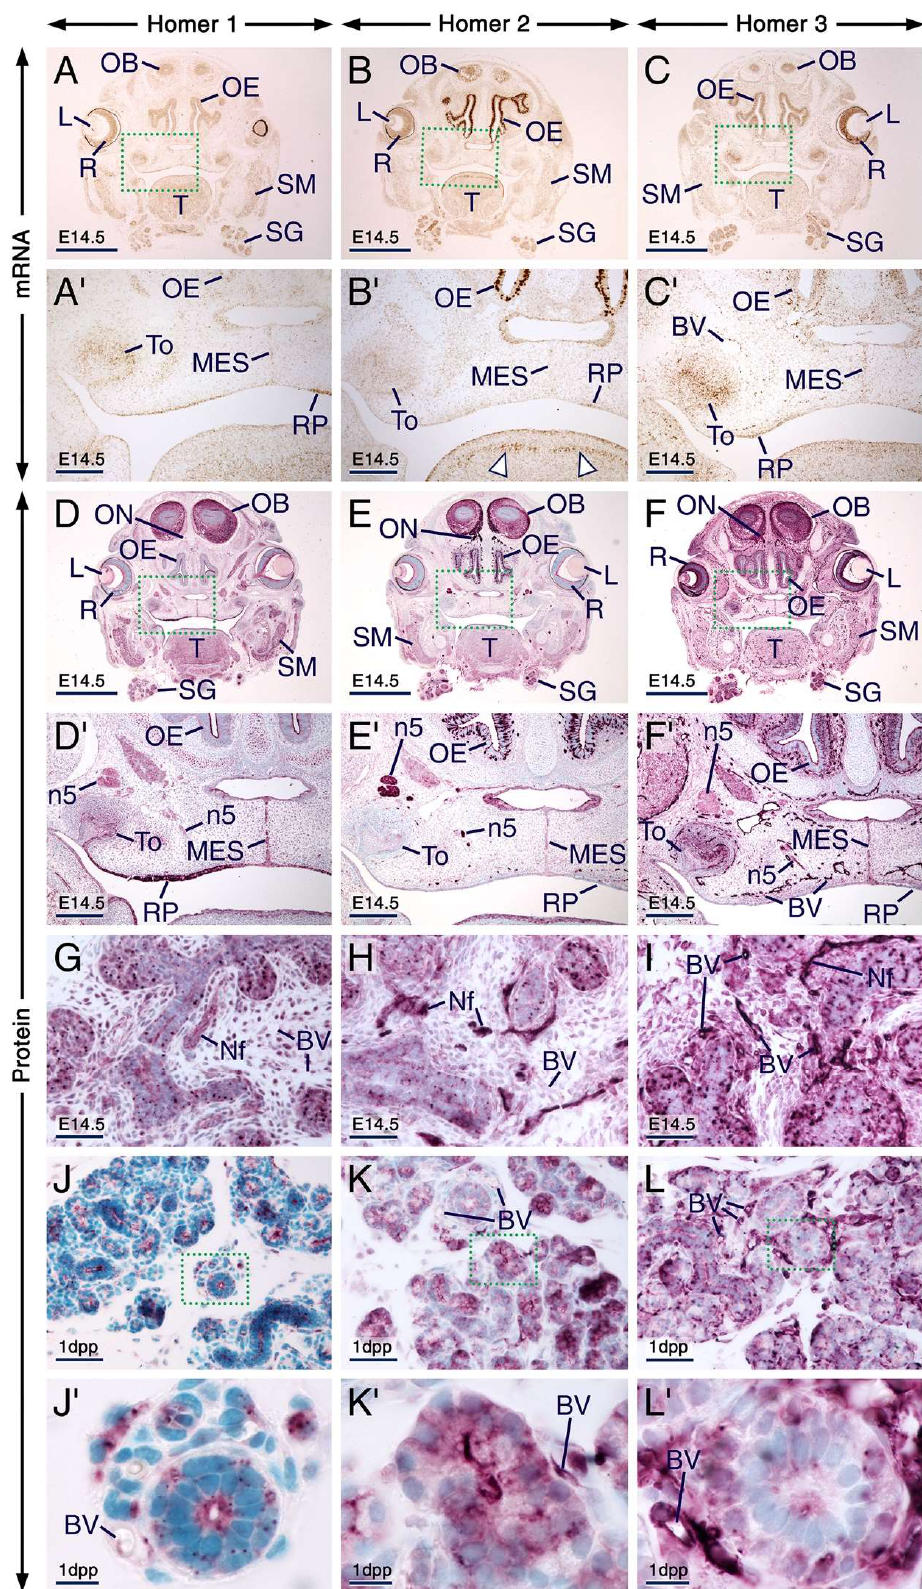
Figure 5. Expression patterns of Homer1, Homer2 and Homer3 in neuronal and non-neuronal cephalic tissues. ( A – I ) Representative sections across cephalic tissues at embryonic day 14.5 (E14.5) after in